Question: Give a one-sentence summary of this figure.
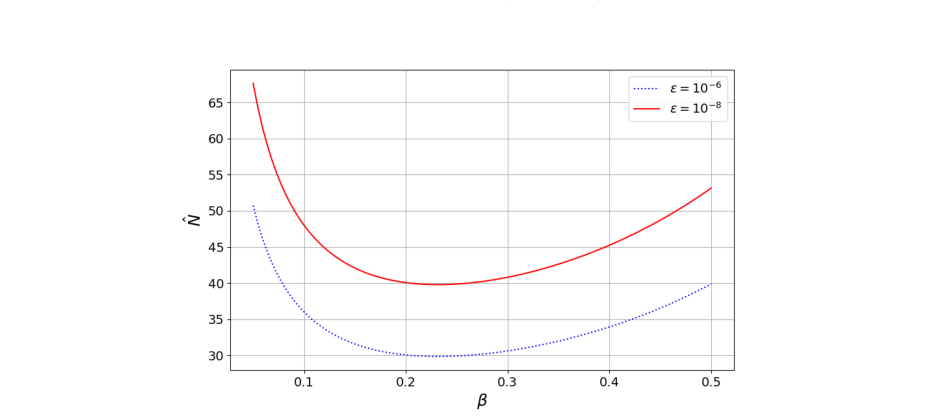
Answer: Upper bound ˆN on the number of box iterations.